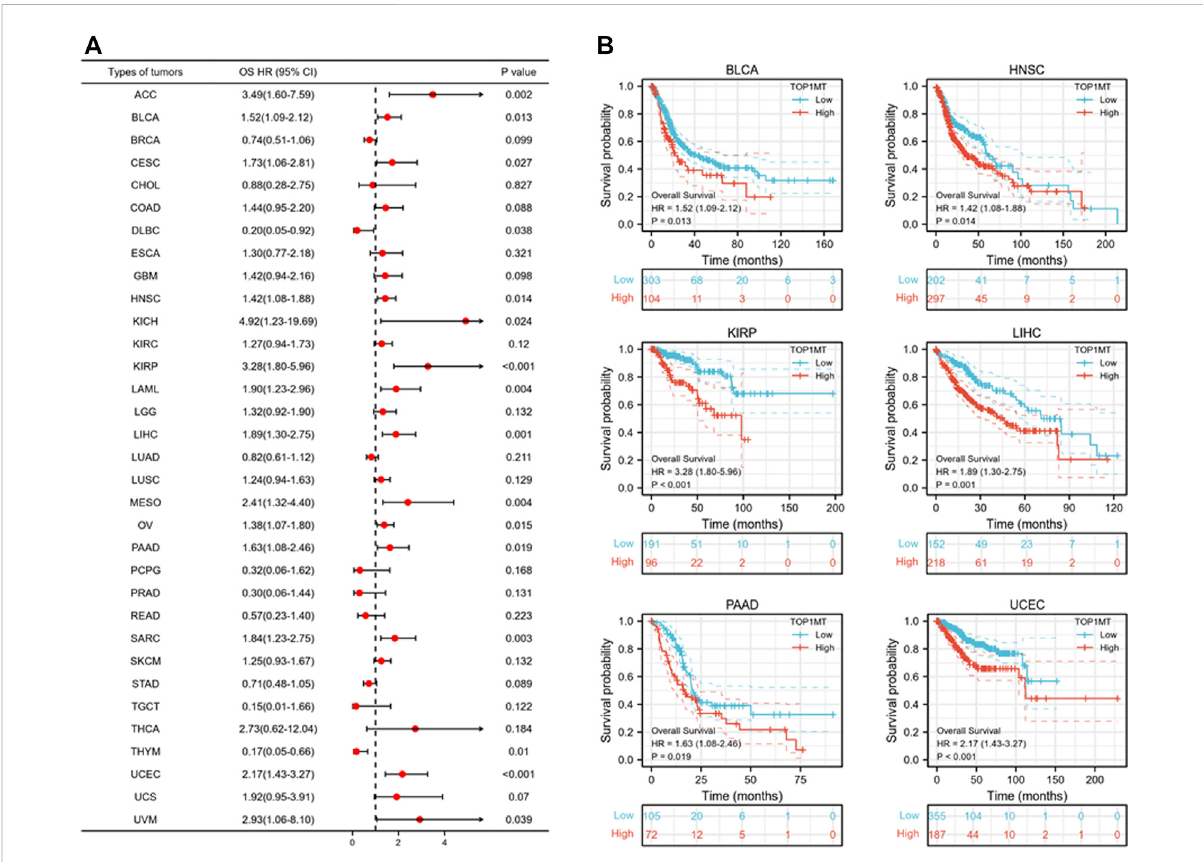
FIGURE 2 Relationship between TOP1MT expression and OS in cancer patients. (A) Forest map of TOP1MT risk ratios in 33 tumors; (B) Kaplan-Meier survival curves of OS in BLCA, HNSC, KIPP, PAAD, UCEC, and LIHC patients. p p < 0.05, pp p < 0.01 and pp p <